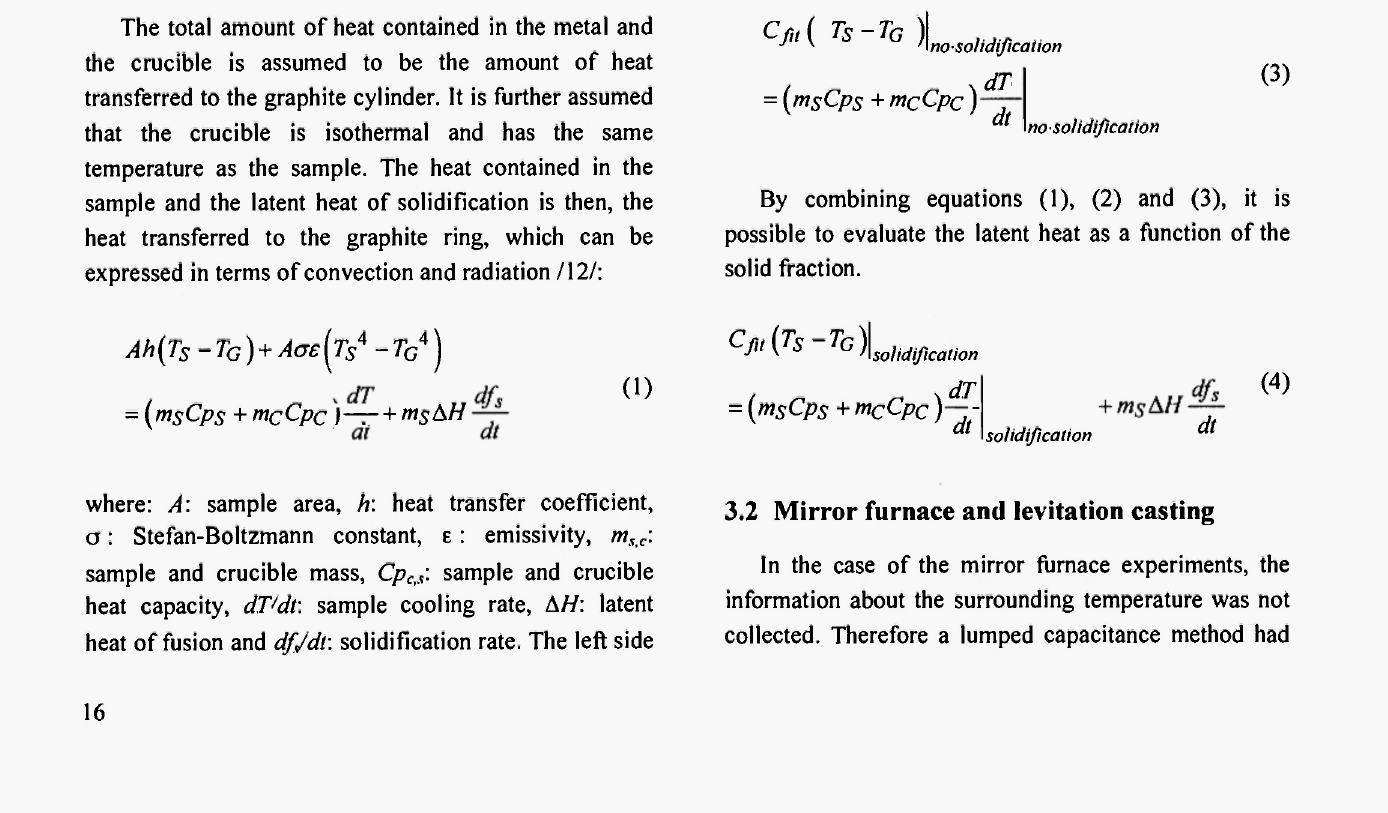
Fig. 3: a) Schematic representation of levitation